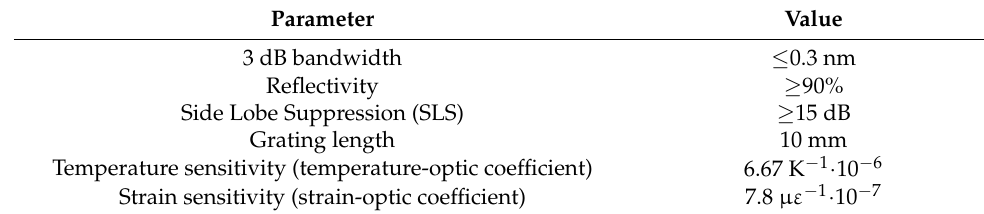
Table 1. The main parameters of FBG